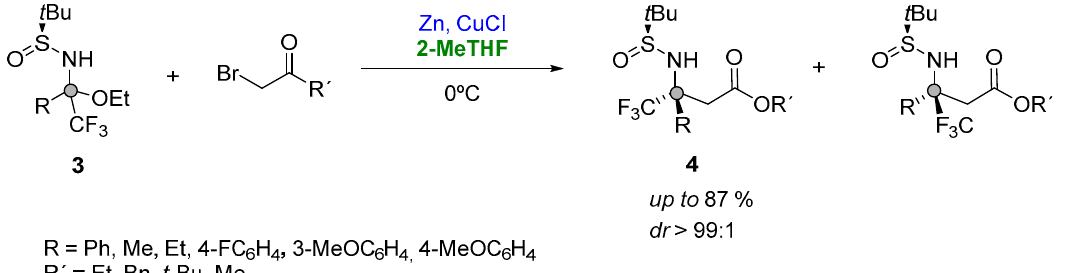
Figure 4. Organozinc addition to a quaternary carbon center.